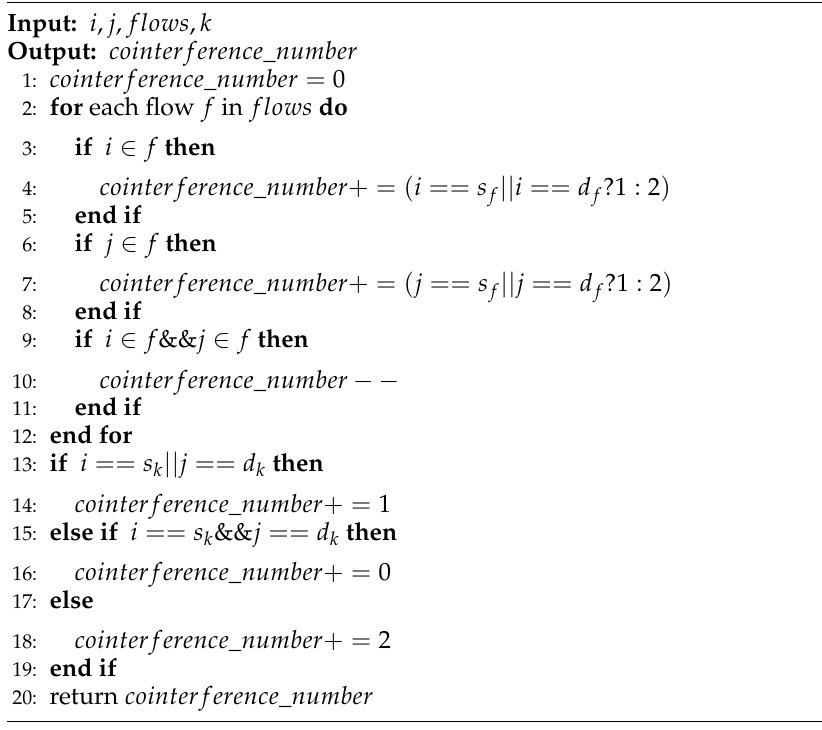
Algorithm 4 Interference link number Algorithm